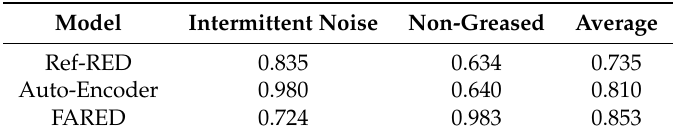
Table 6. AUC of anomaly detection in the same manufacturing